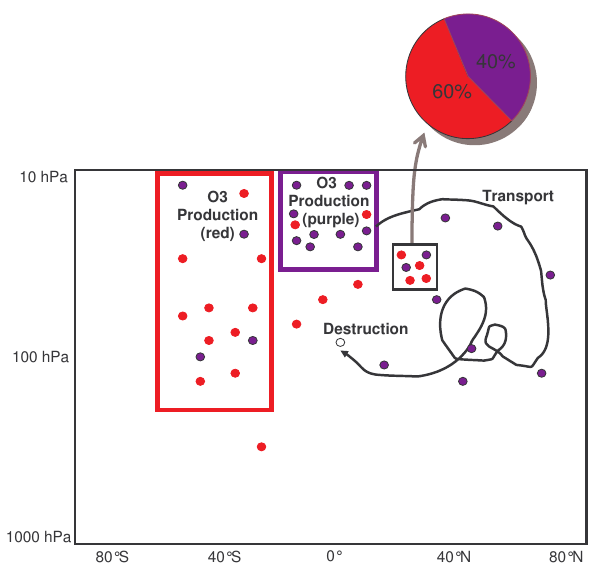
Fig. 1. Schematic illustrating the ozone origin diagnostic. Two